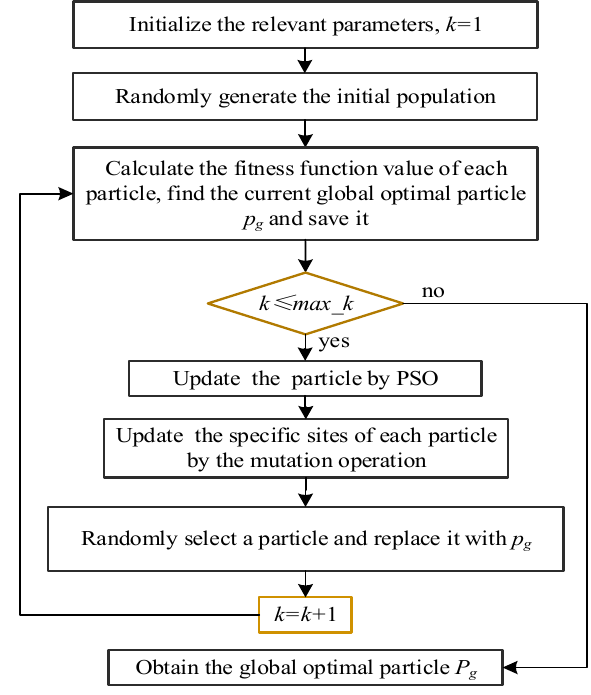
Figure 2. GA–PSO hybrid algorithm flowchart.